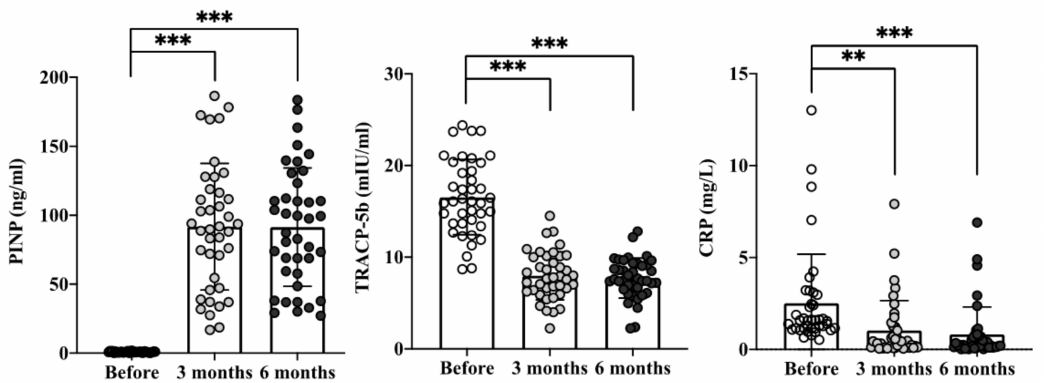
Figure 4. Cinacalcet treatment upregulates PINP expression to activate osteoblasts responsible for bone formation and downregulates TRACP-5b expression to inhibit osteoclastic bone resorption along with CRP suppression at the 3rd and 6th month. Quantitative data were analyzed with a paired Student’s t -test. ** p < 0.01; and *** p < 0.001 to compare the di ff erences between the two indicated